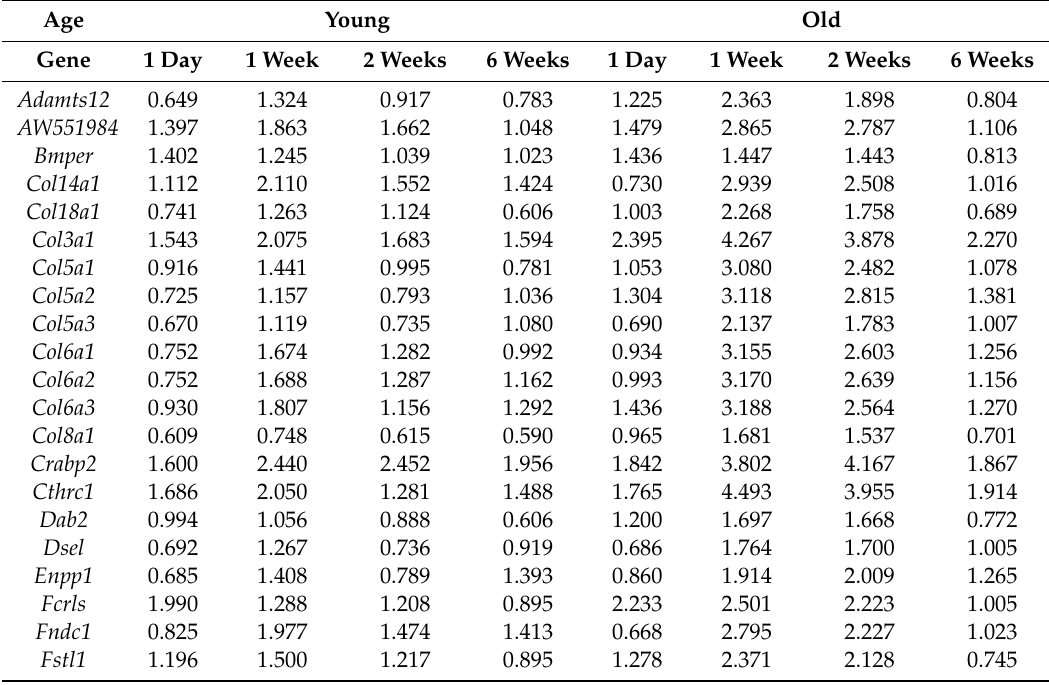
Table 2. Genes up-regulated in injured joints of both young and old mice at all timepoints examined. Fold change (log2 scale) values are shown in the table (false discovery rate (FDR) < 0.05 for all